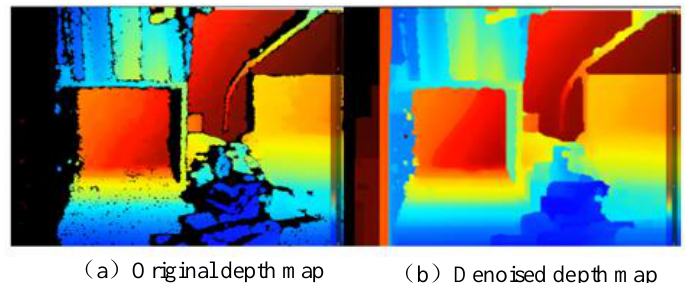
Figure 5. Denoising